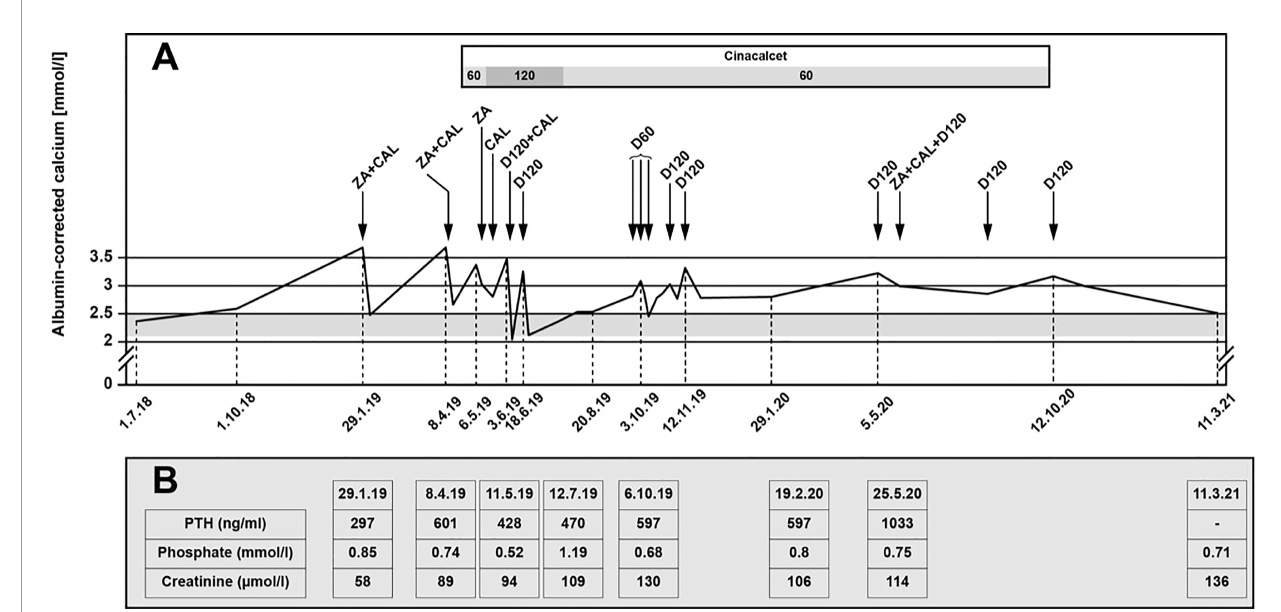
FIGURE 2 | (A) Calcium levels under therapy with denosumab. ZA, zoledronic acid; CAL, calcitonin; D60, denosumab 60 mg; D120, denosumab 120. (B) Selected PTH, phosphate and creatinine levels. PTH, parathyroid